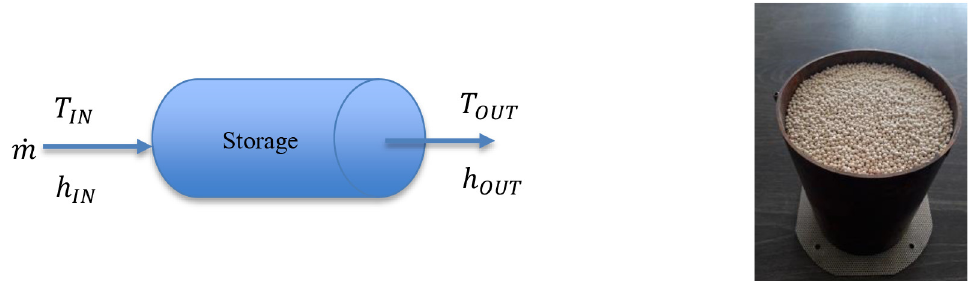
Fig. 2. Fixed bed reactor shown without additional appliances (right) and schematic view